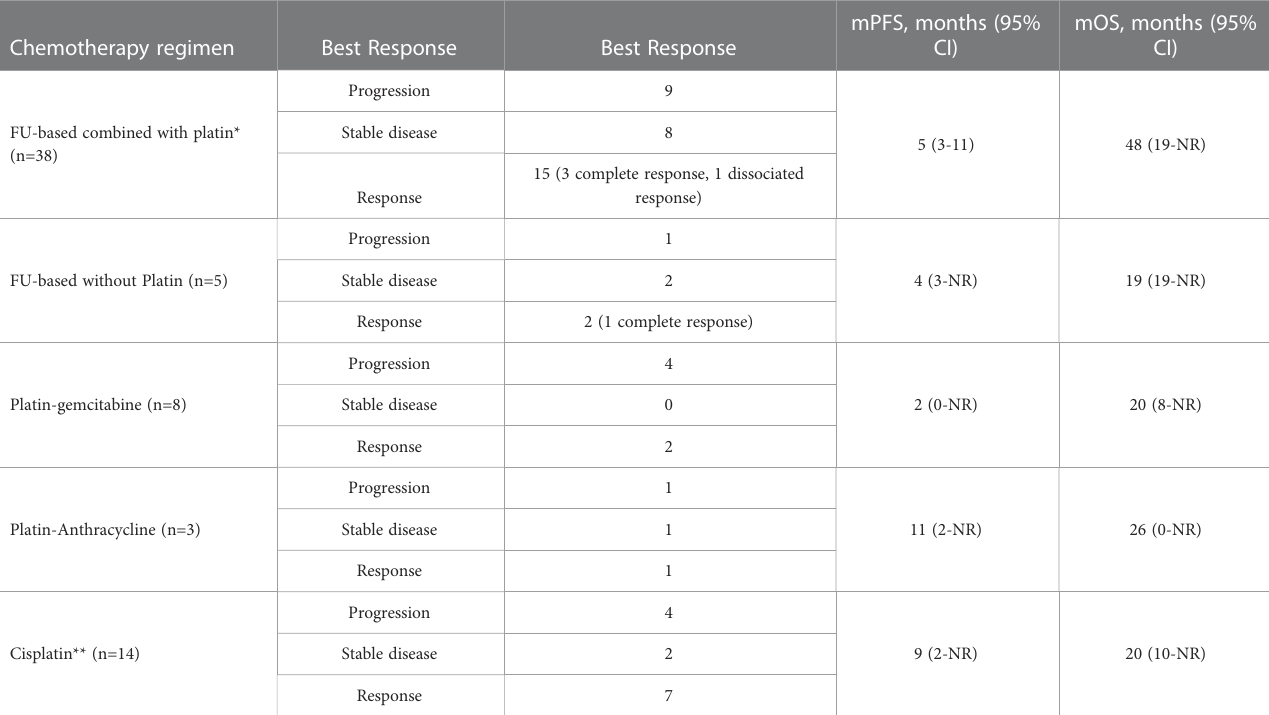
TABLE 2 Treatments and survival for patients with metastatic